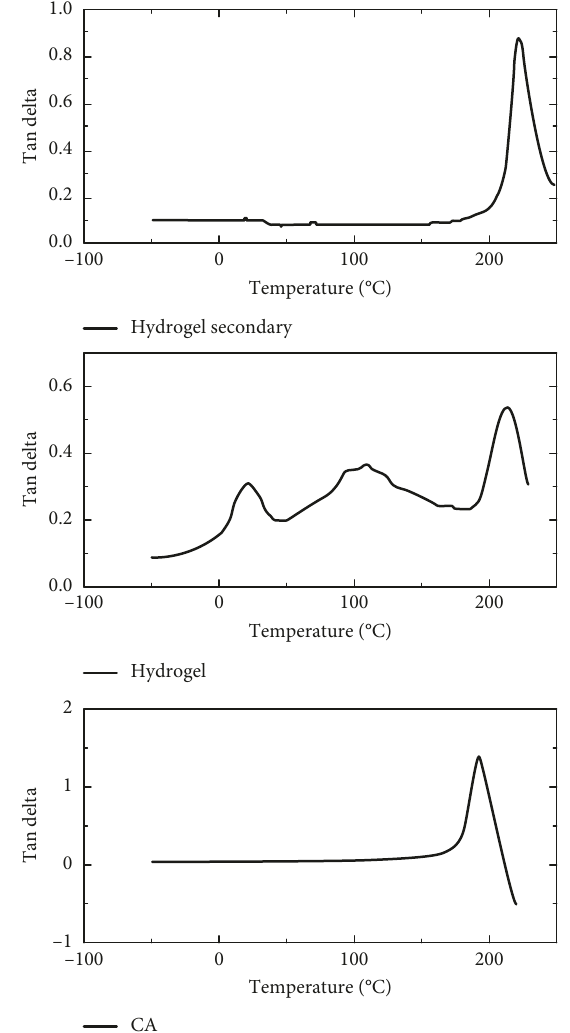
Figure 7: Tan delta dry hydrogel, swollen hydrogel, and cellulose acetate (CA) between − 50 and 250 °